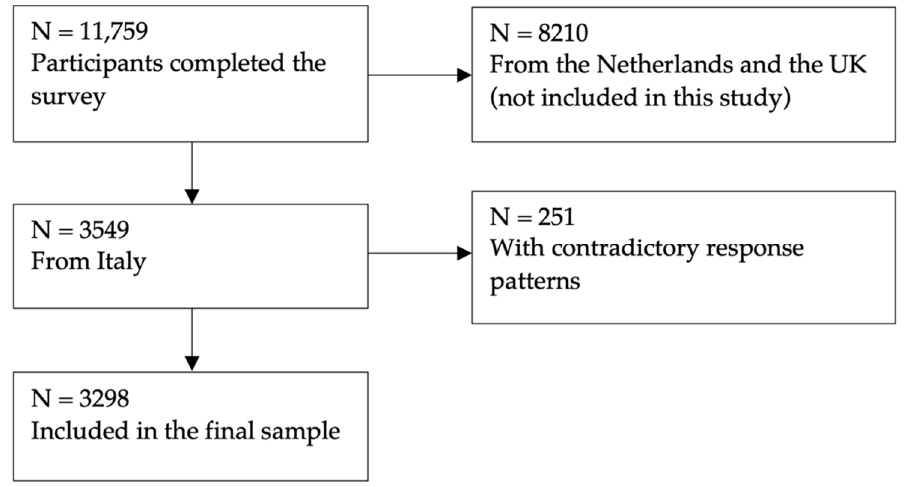
Figure 1. General population sample attrition